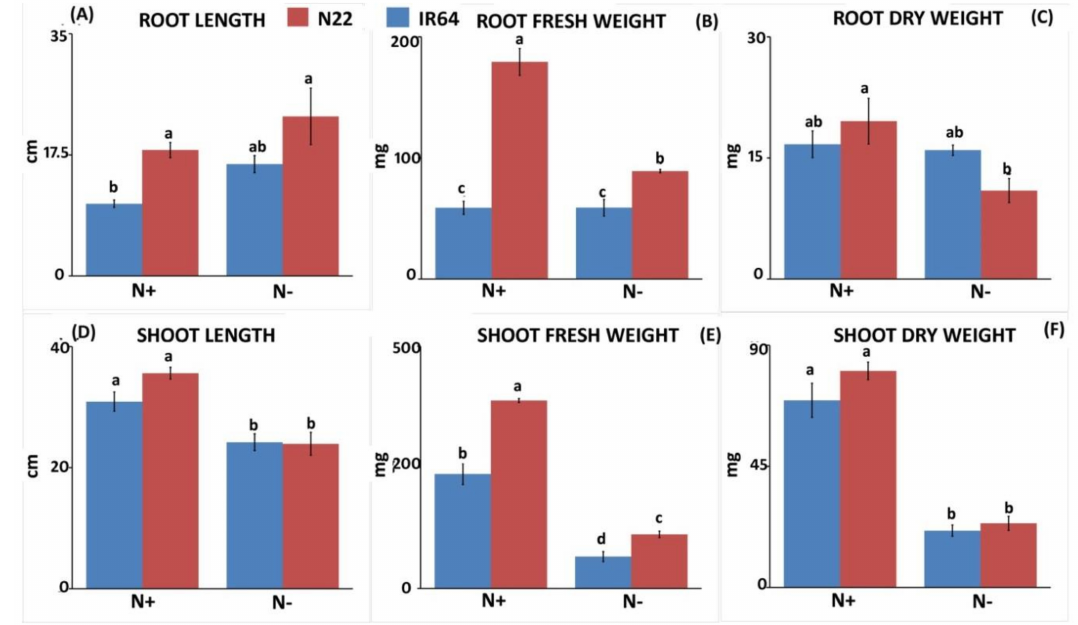
Figure 1. Root and shoot biomass parameters in two rice genotypes, IR 64 and Nagina 22, under optimal (N+) and low nitrogen (N) (N − ). ( A ) Root length; ( B ) Root fresh weight; ( C ) Root dry weight; ( D ) Shoot length; ( E ) Shoot fresh weight; ( F ) Shoot dry